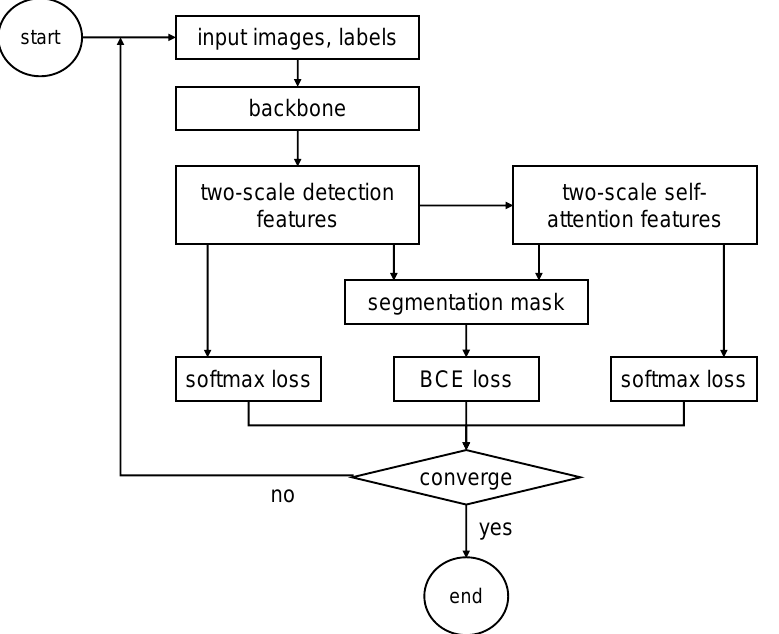
Figure 2. Flow chart of our proposed two-branch